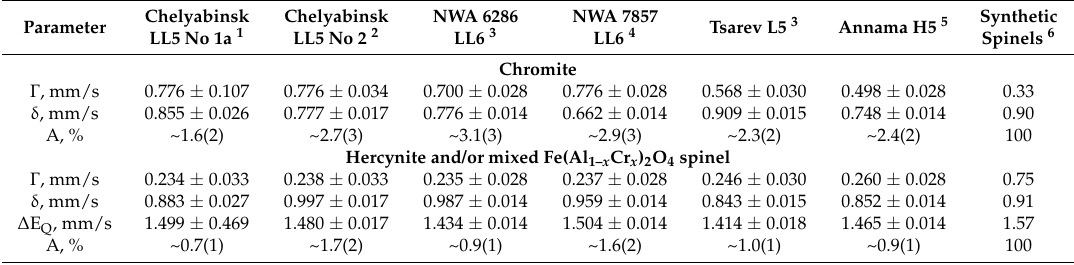
Table 3. Mössbauer parameters for spinels found in the bulk ordinary chondrites in comparison with data obtained for synthetic spinels.